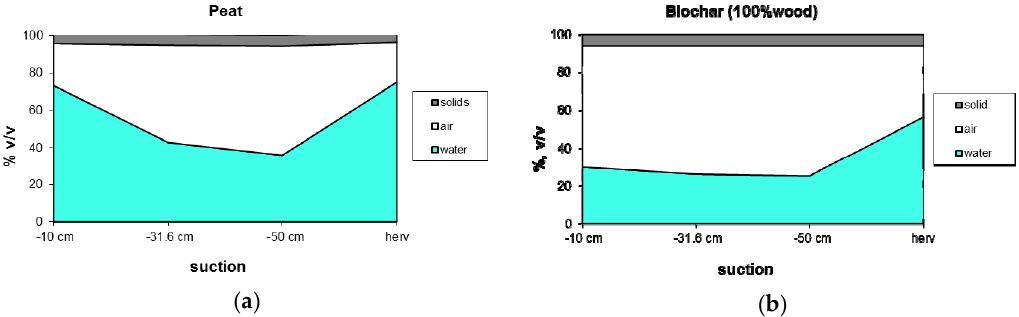
Figure 1. Water content of peat ( a ) and 100% v/v biochar from wood chips ( b ) in % v/v as a function of suction strength in cm water column. The water holding capacity of 100% v/v wood biochar of 3–4 mm grains is low compared to peat and too low to ensure sufficient water supply to plants. The higher water ‐ content after re ‐ saturation compared to the initial situation is partly explained by re ‐ arrangement of the biochar particles leading to an increase in the presence of small pores.